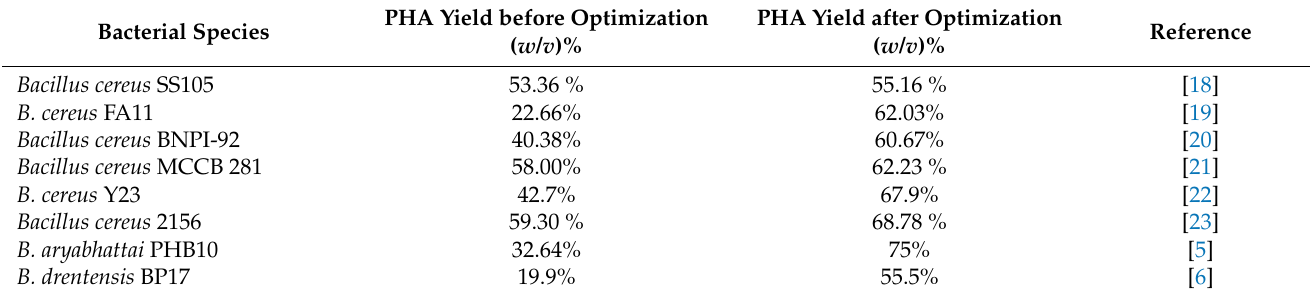
Table 1. Effect of optimization on the yield of PHA ( w / v %) in different strains of Bacillus species. PHA Yield before Optimization PHA Yield after Optimization Bacterial Species Reference ( w / v )% ( w / v )% Bacillus cereus SS105 53.36 % 55.16 % 22.66%